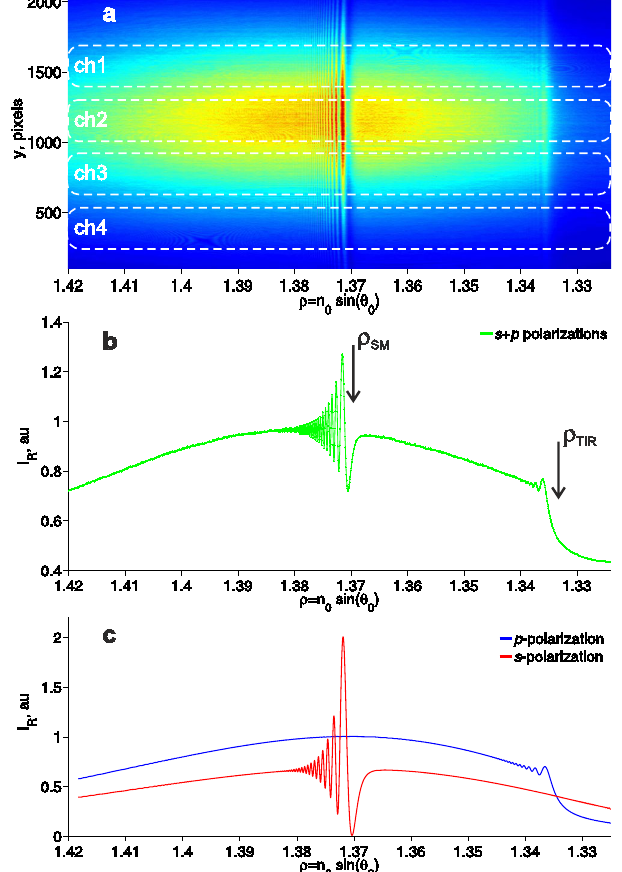
Figure 2. The reflected profiles containing data on the excitation angles of the surface mode (SM) resonance and the total internal reflection (TIR) angle. ( a ) The experimental data recorded by means of a CMOS matrix. The boundaries of the four fluid channels are indicated by dotted white lines. ( b ) Experimental data on the sum of all horizontal lines of the matrix. Arrows indicate the angle of excitation of the SM ( ρ SM = n 0 sin( θ SM )) and the angle of the TIR ( ρ TIR = n 0 sin( θ TIR )). (c) Theoretical calculation of the reflection profiles for s- and p-polarizations. The fine interference structure near ρ SM and ρ TIR is explained in detail in 15